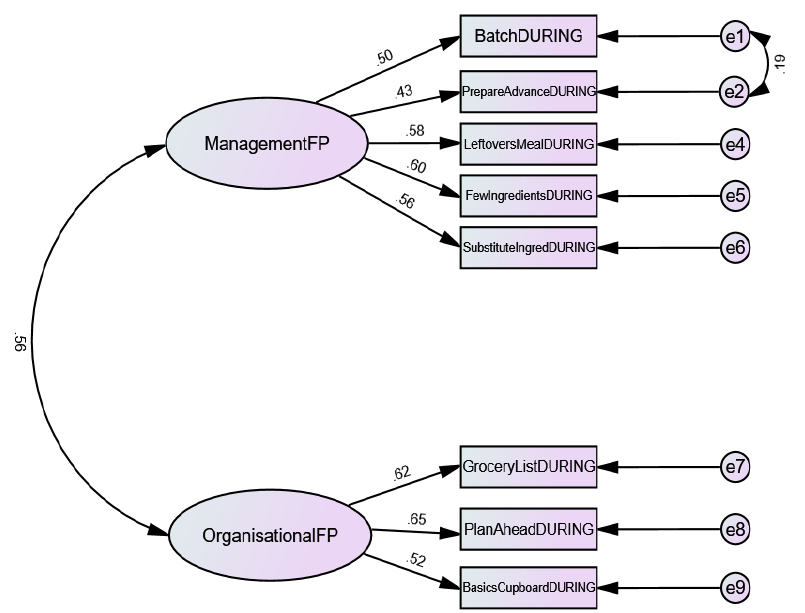
Figure 1. Final measurement model for Emergency Situation Food Practices with standardized factor loadings and correlations. FP: Food Practices; e1–9: error term for each variable.